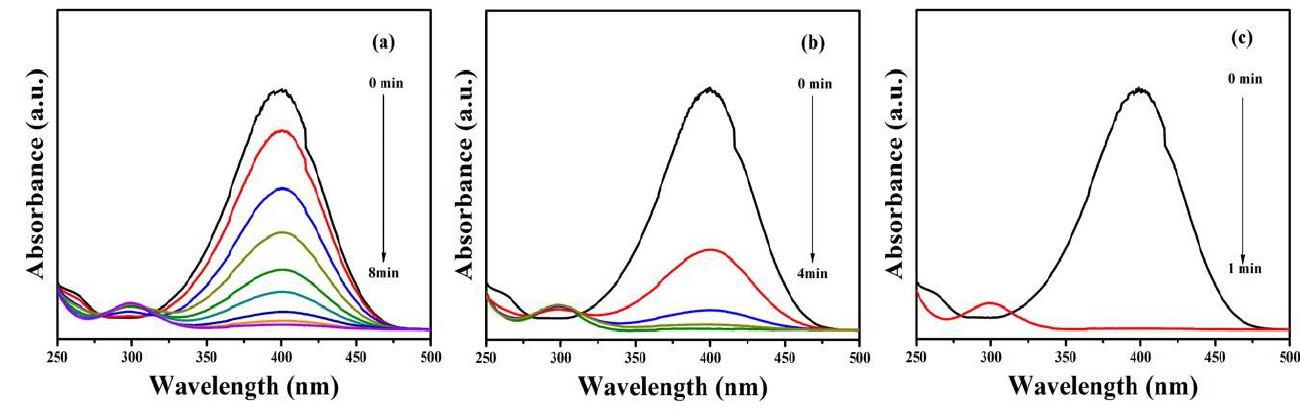
Figure 7. UV-Vis spectra of 4-NP reduction reaction via ( a ) CoPt, ( b ) rGO/CoPt, and ( c ) rGO/CoPt/Ag catalysts.